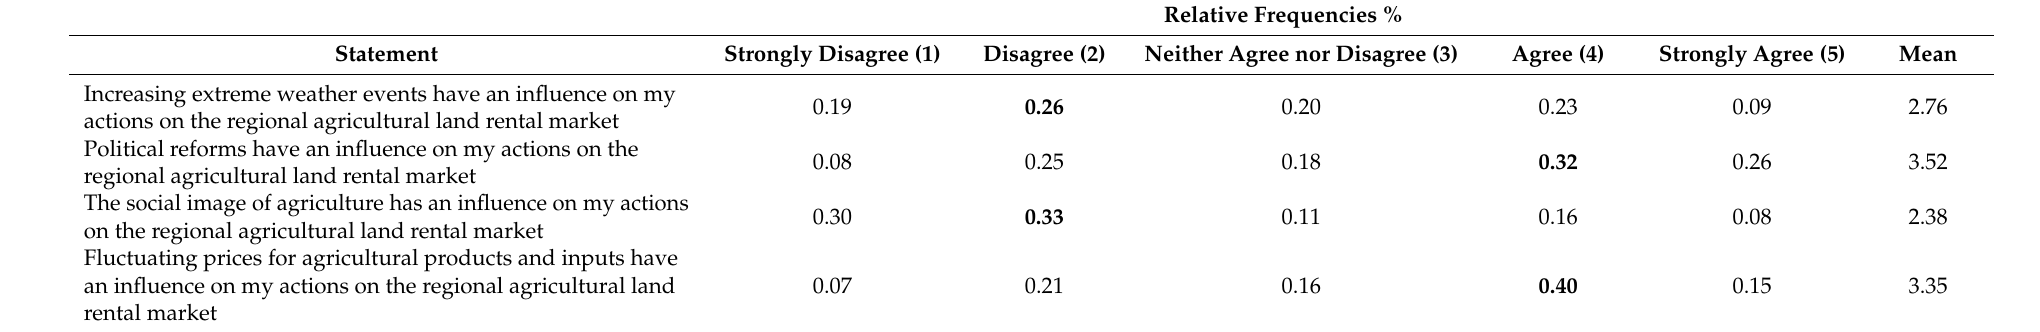
Table 5. Descriptive statistics and distribution of responses concerning the ability to act on the agricultural land rental market for Likert scales (1 = strongly disagree; 5 = strongly agree), (N =